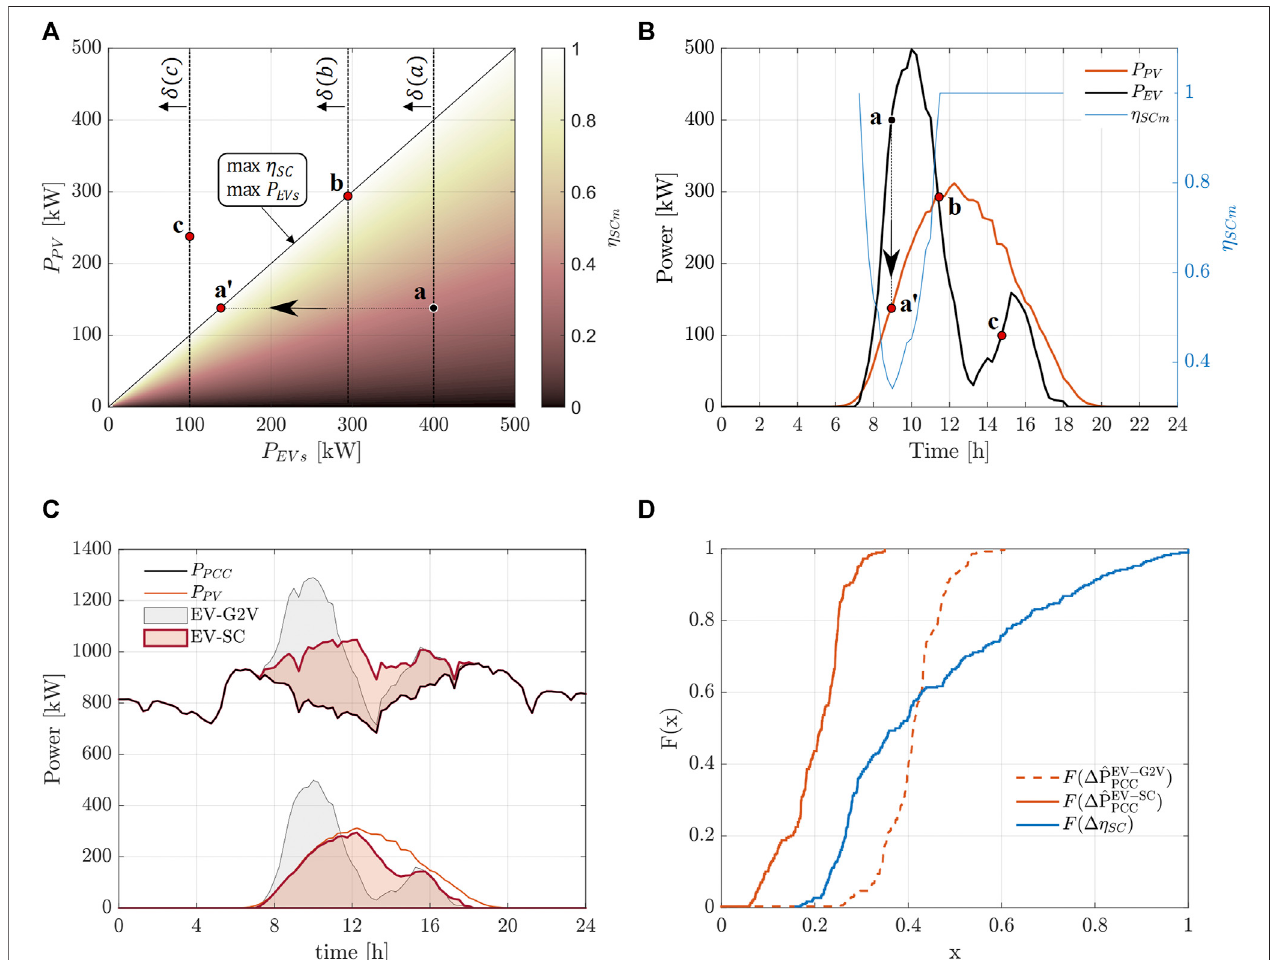
FIGURE 6 | (A) The 1 min charging self-consumption ( η SCm ) as a function of P PV and P EVs . The white zone depicts points ( P PV ; P EVs ) that maximize η SCm . (B) Example of P PV and P EVs daily pro fi le and the corresponding value of η SCm (right axis) considering three possible operating conditions, P EVs > P PV , P EVs (cid:2) P PV , and P EVs < P PV , depicted by the markers a , b , and c , respectively. The CMS moves the point a toward a ’ to ful fi ll the optimization objective. (C) 24 h comparison between standardG2VandSCandtheireffectsonthe P PCC and P EVs powertraces. (D) Cumulativedistributionof Δ (cid:9) P PCC incaseofstandardG2V(reddashedtrace)andSC (red line) over a 1-year period, together with the gain in charging self-consumption Δ η SC (blue